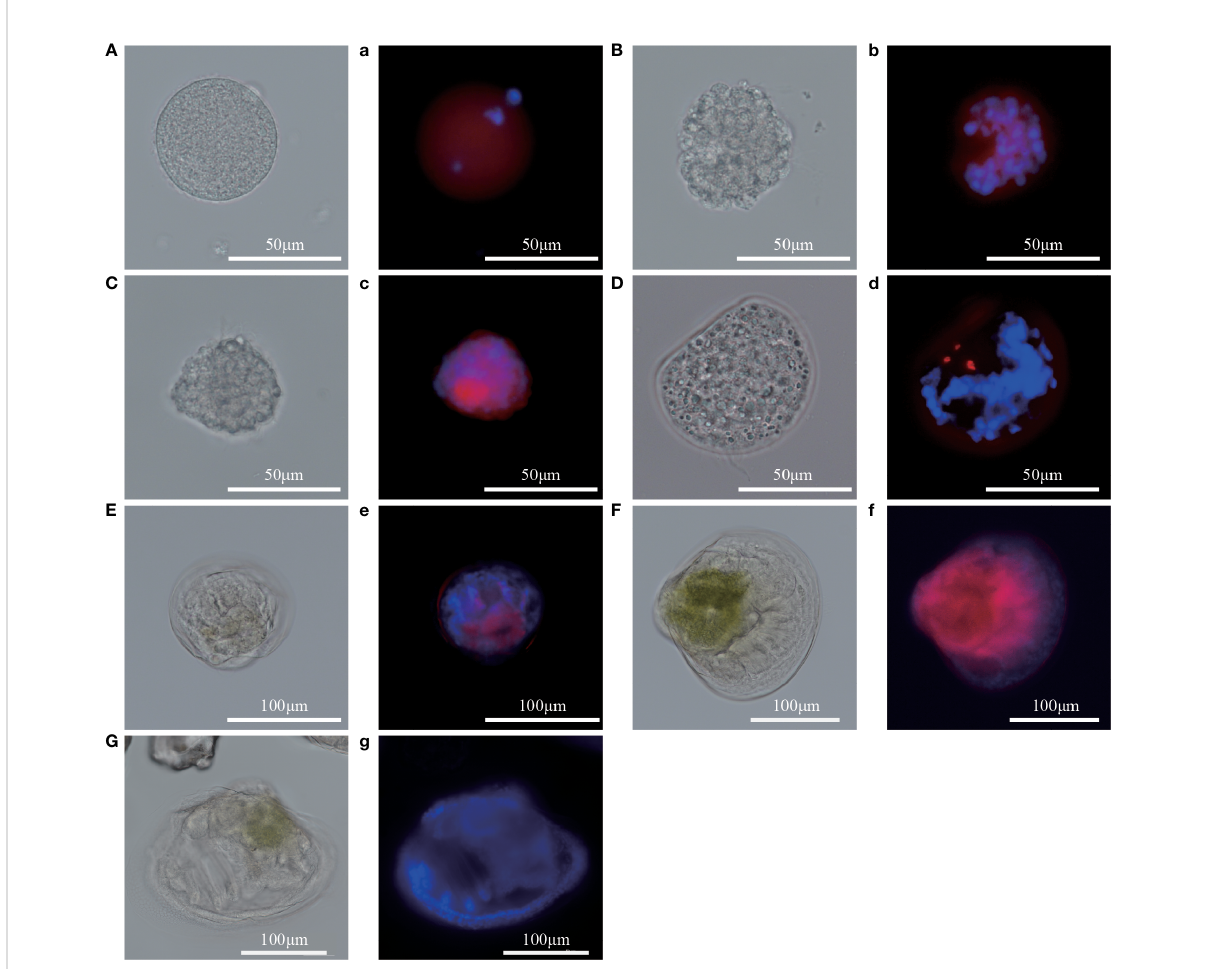
FIGURE 6 In situ hybridization results of Pm5-HTR2 at the developmental stage. (A – G) photos of the experimental group under white light; (a – g) photos of the experimental group under fl uorescent light. (A/a) , fertilized ovum; (B/b) , blastocyst; (C/c) , trochophore; (D/d) , D larvae; (E/e) , umbo larvae; (F/f) , eyed larvae; (G/g) , juvenile. Red fl uorescence: in situ hybridization signal of the gene; blue fl uorescence: